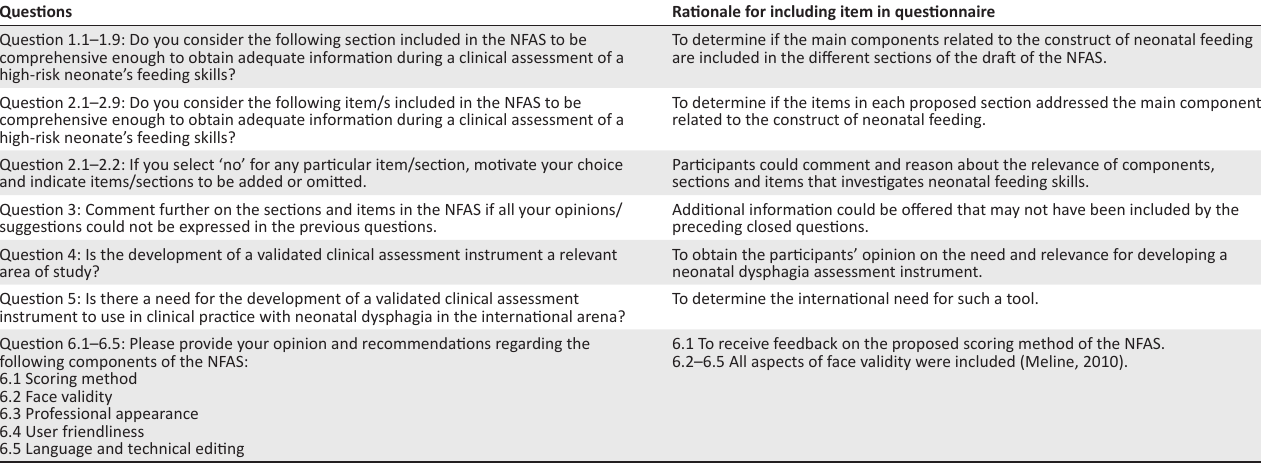
TABLE 2: Content and rationale for expert panel questionnaire